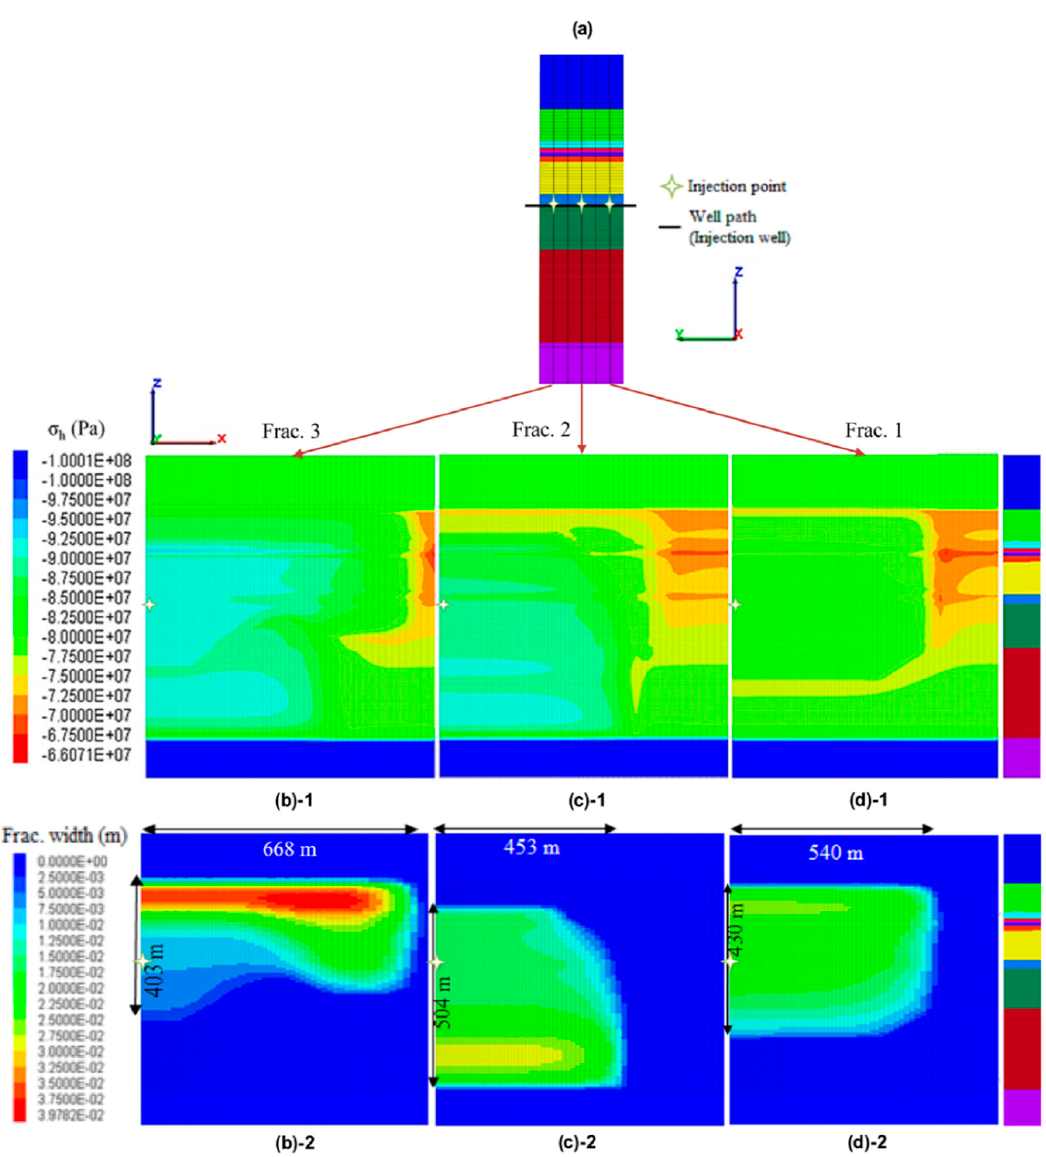
Figure 17. Minimum horizontal stress along three fracture planes and fracture widths with 60 m spacing.